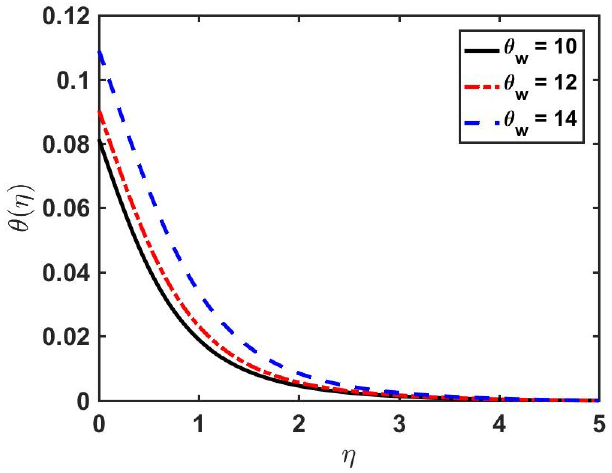
Figure 7. Effect of 𝜽 𝒘 on 𝜽(𝜼) .